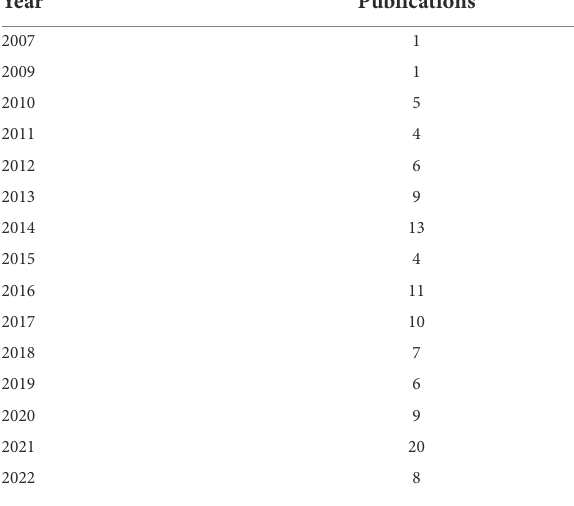
TABLE 1 Annual article